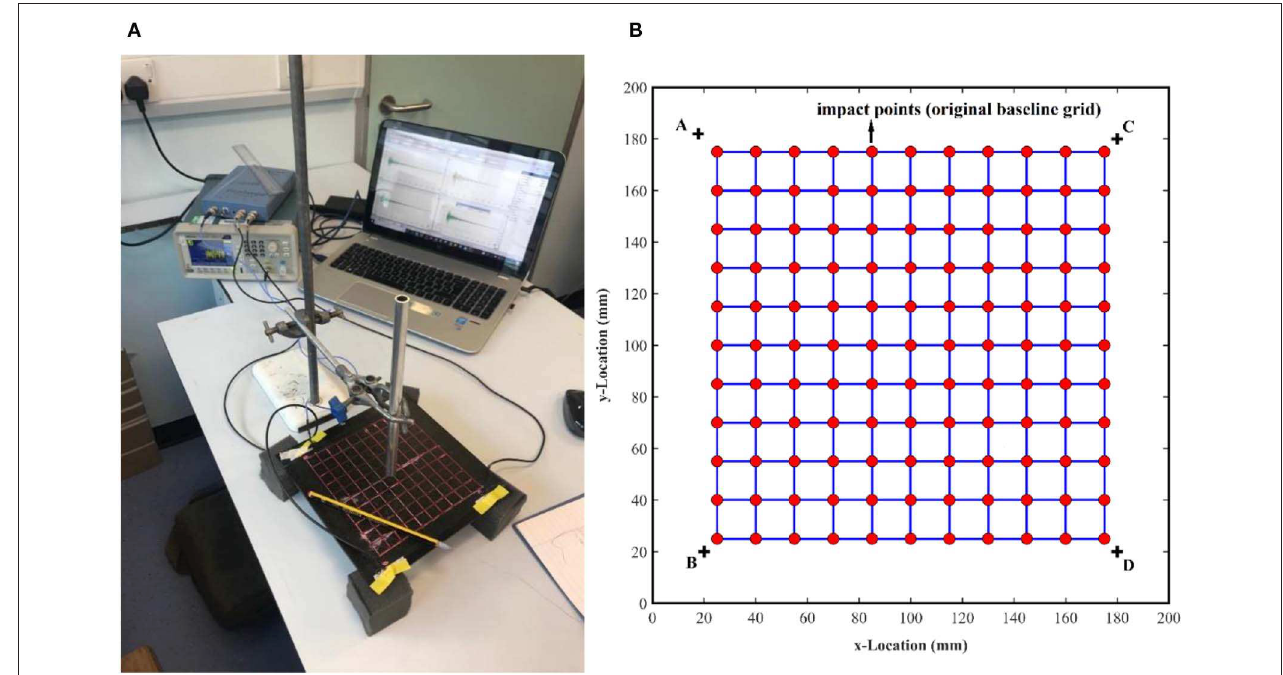
FIGURE 2 | Experimental set-up configuration (A) and CFRP plate baseline original grid and sensor configuration (B) .